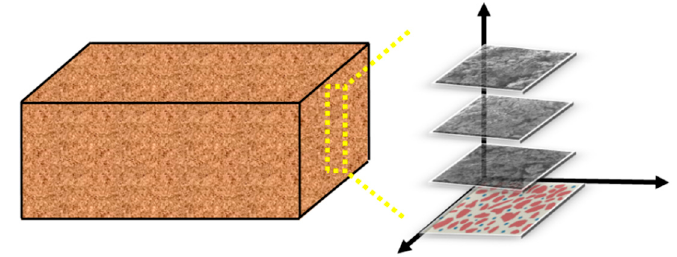
Figure 2. SEM images. ( a ) SEM image of upper soil; ( b ) SEM image of middle soil; ( c ) SEM image of subsoil.